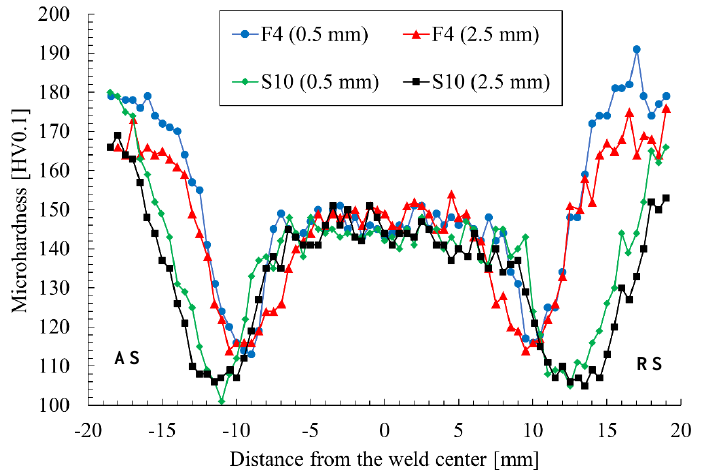
Figure 8. Microhardness profile of the FSW joints at the distance of 0.5 and 2.5 mm from the weld face.